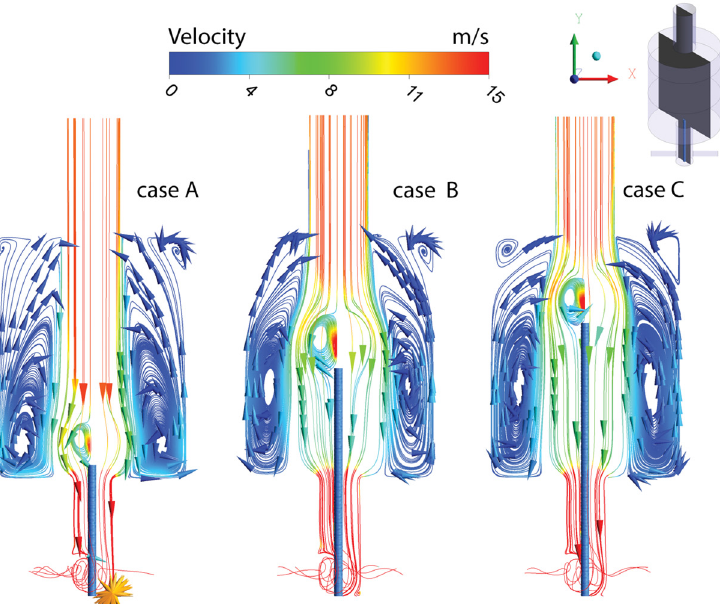
Figure 6. Air streamlines across the central axial cross-sectional plane (XY) for three different nozzle locations, A = 3 cm (left); B = 23 cm (middle); C = 33 cm (right) (to introduce more clarity, the maximum value of the velocity has been restricted to 15 m/s).